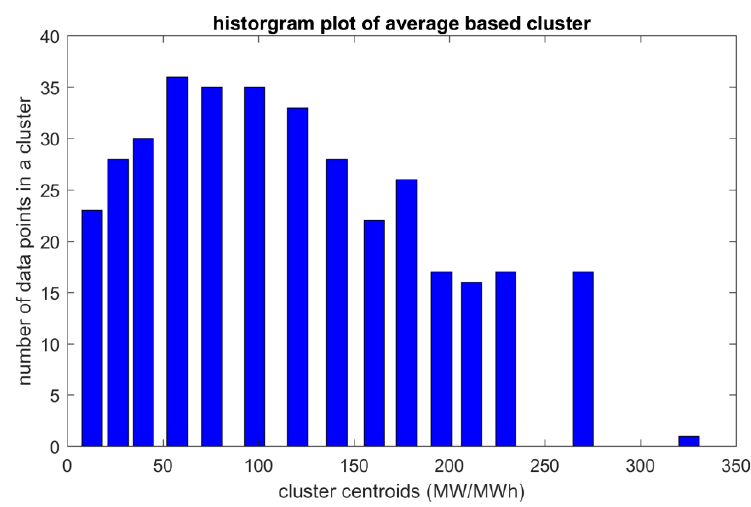
Figure 6. Representative data histogram plot (daily average based).